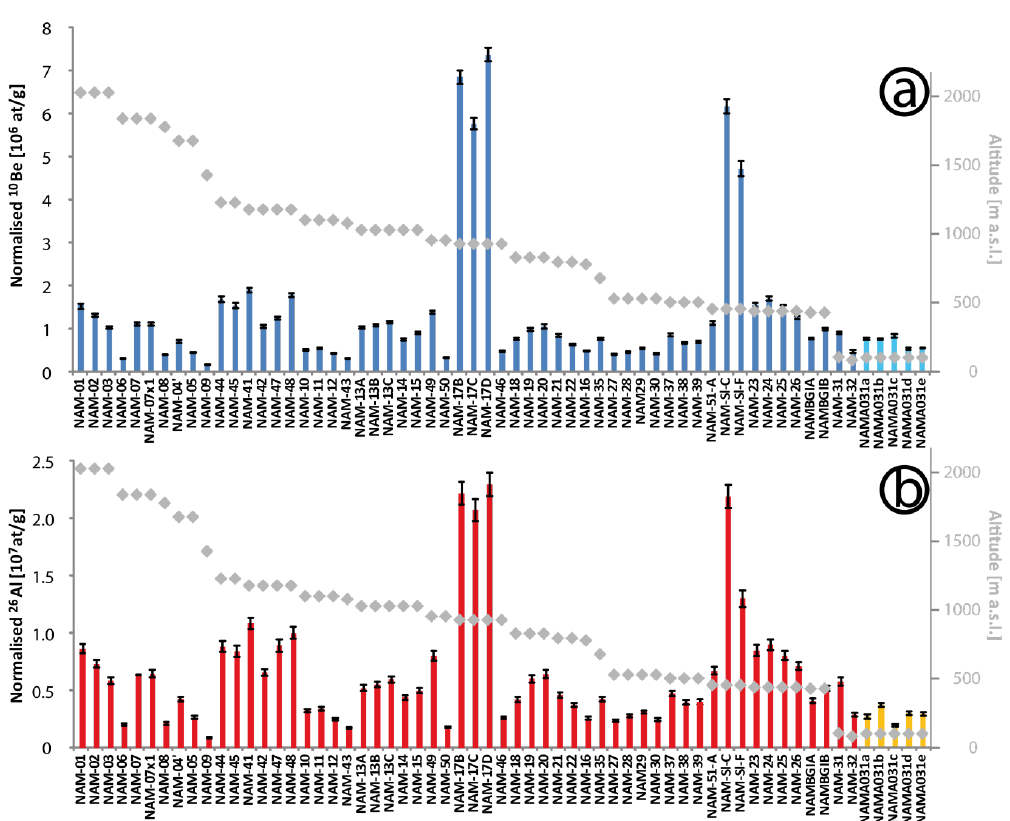
Figure 4. Normalised ( a ) 10 Be and ( b ) 26 Al concentrations versus altitude of the sample location in samples of [27] and from this study (the five rightmost samples of panels a and b, i.e., NAMA031 a-b-c-d-and e).